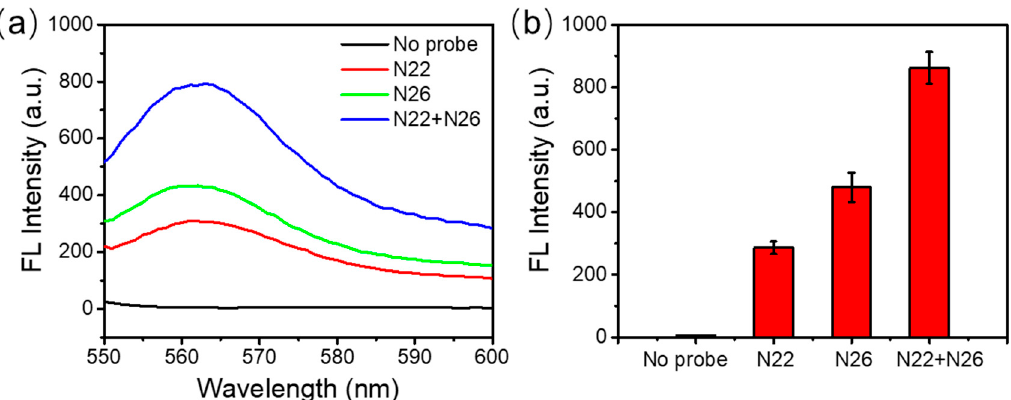
Figure 4. Multiple probe incorporation. ( a ) Fluorescence emission spectra with different probes. ( b ) The peak fluorescence values with different DNA probes.